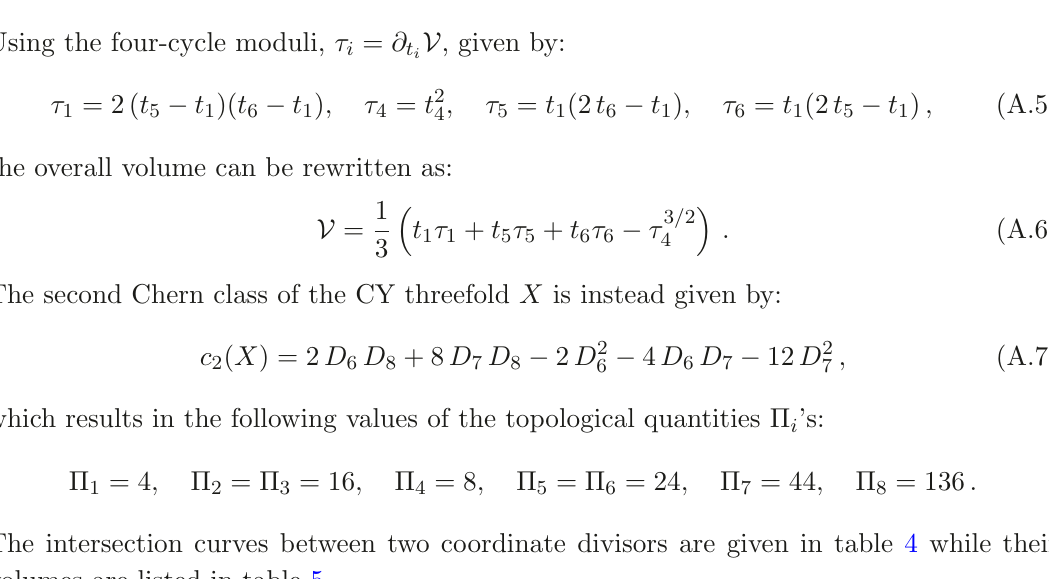
Table 5 . Volumes of intersection curves between two coordinate